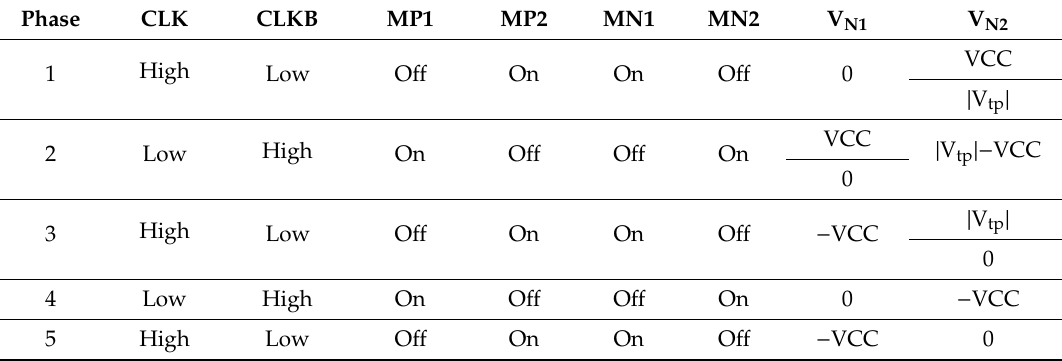
Figure 2. Conventional cross-coupled hybrid pumping circuit (Conv 1) [2]. Table 1. Sequential operation for the conventional circuit Conv1.